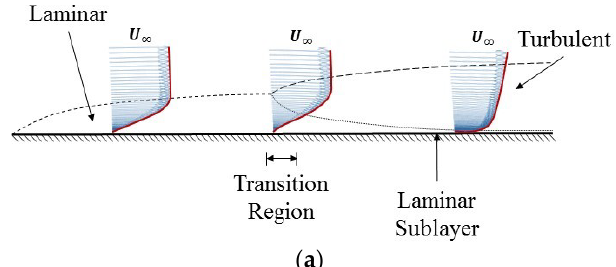
Figure 11. Cont. Figure 11.